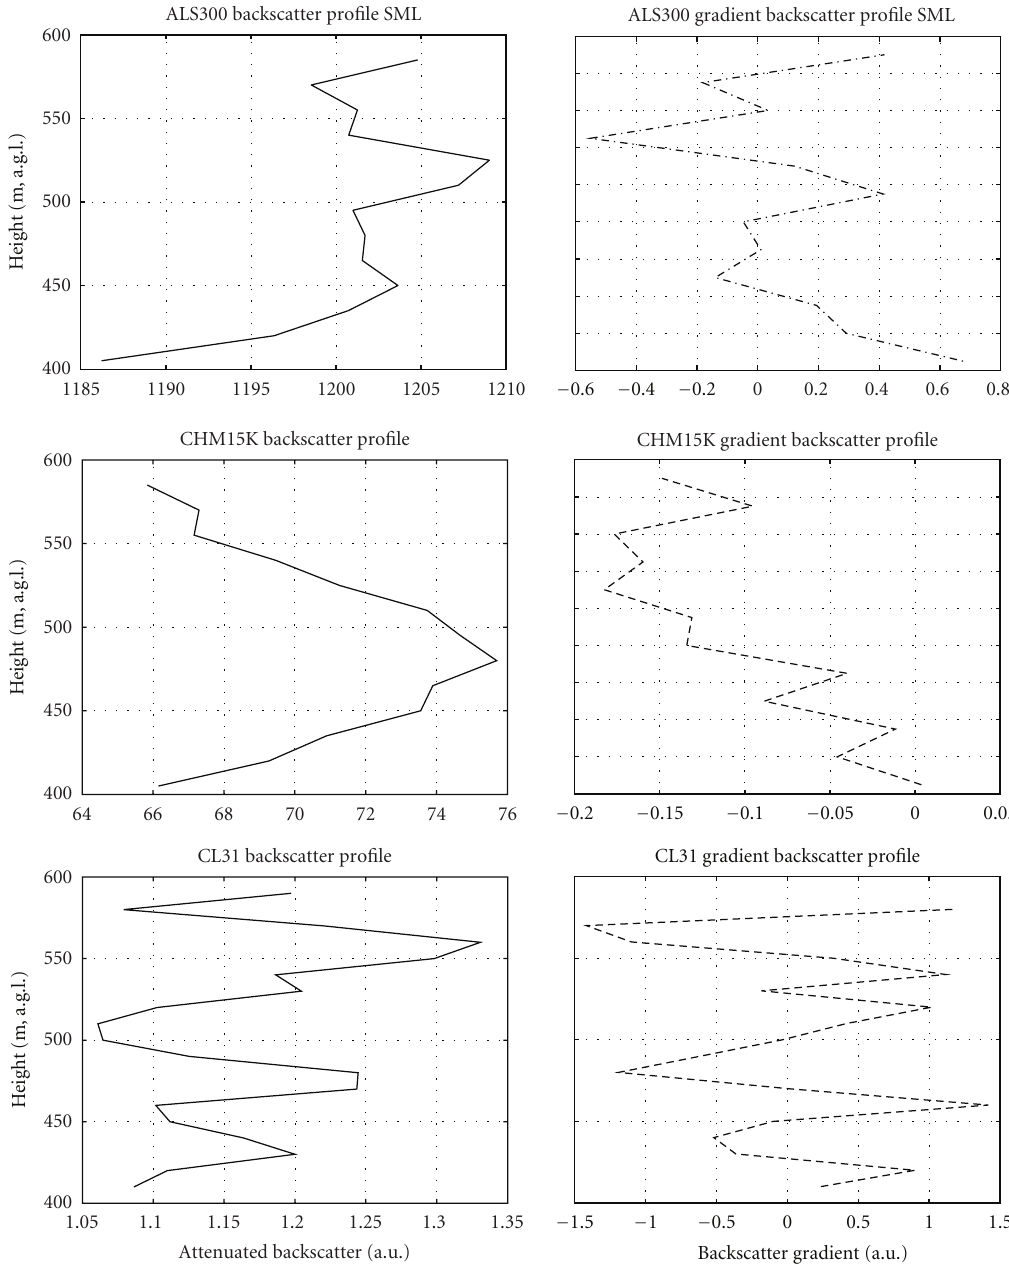
Figure 11: 400 m to 600 m height section of ALS300, CL31 and CHM15K’s 10 minute average of backscatter (left hand side panel) and gradient backscatter (right hand side panel) for the 12th of Jun 2009, 11:15